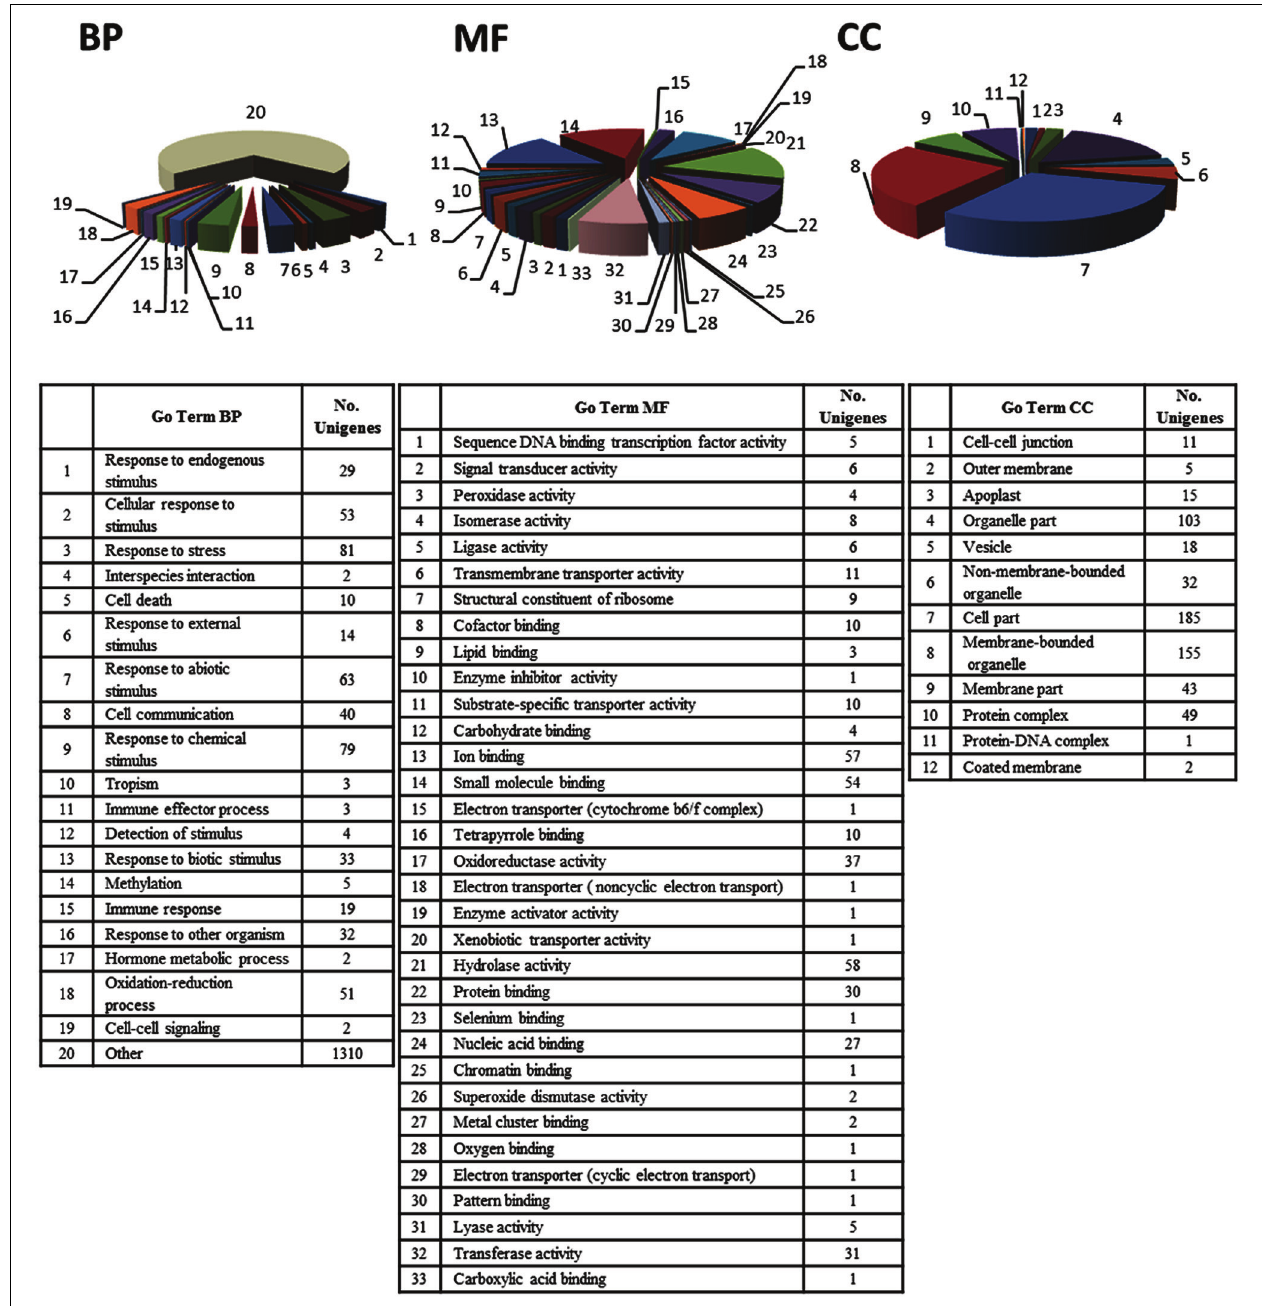
FIGURE 2 | “Level 3” Gene Ontology (GO) terms distribution of 376 unigenes induced in olive ( Olea europaea L.) aerial tissues colonized by Pseudomonas fluorescens PICF7. Expressed Sequences Tags (ESTs) were categorized using the “Blast2GO” software according to the terms of the